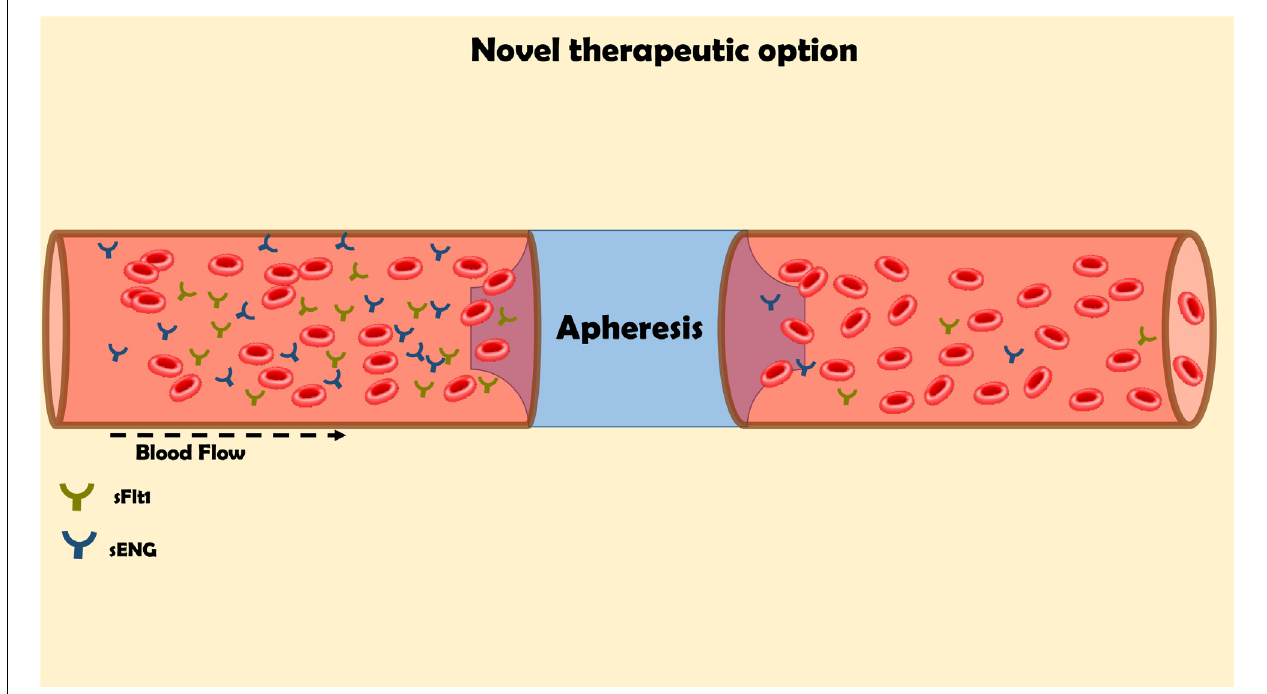
FIGURE 5 | Innovative approach for the elimination of the elevated levels of sFlt-1 by apheresis for the management of preeclampsia. The maternal blood flow through columns, which contains antibodies against sFlt1 in order to remove it from the circulation.